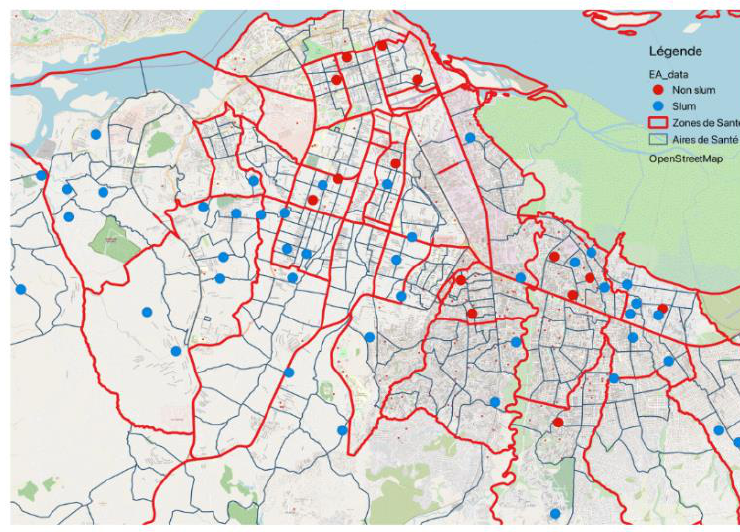
Figure 1. Map of Kinshasa and the 58 selected enumeration areas.